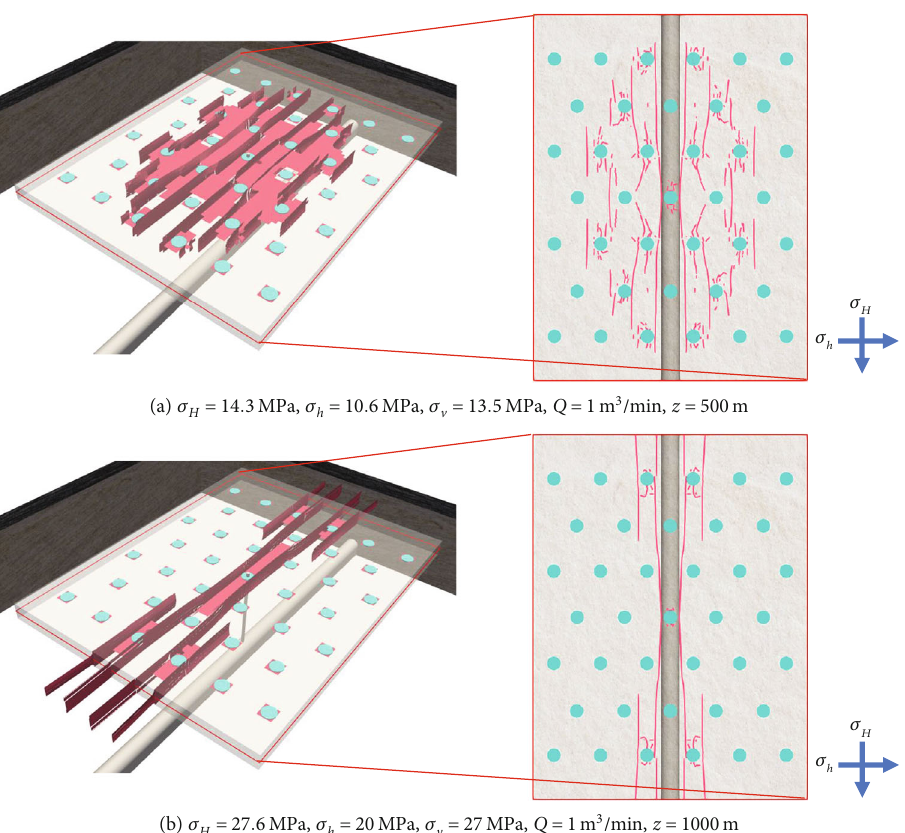
Figure 16: Comparison of hydraulic fracture patterns created by hydraulic fracturing in combination with a staggered distribution of hydraulic slots under (a) low stress di ff erence and (b) high stress di ff